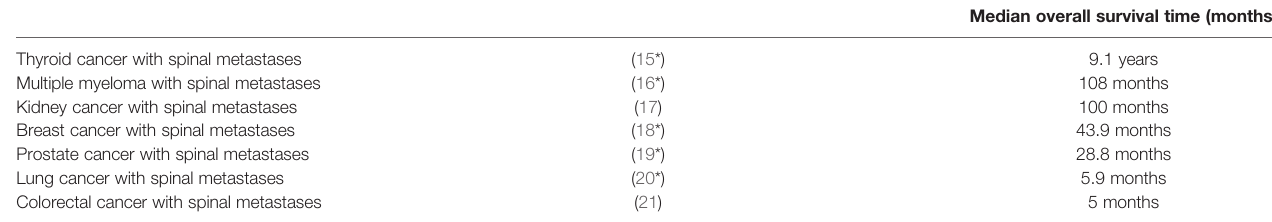
Median overall survival time (months)